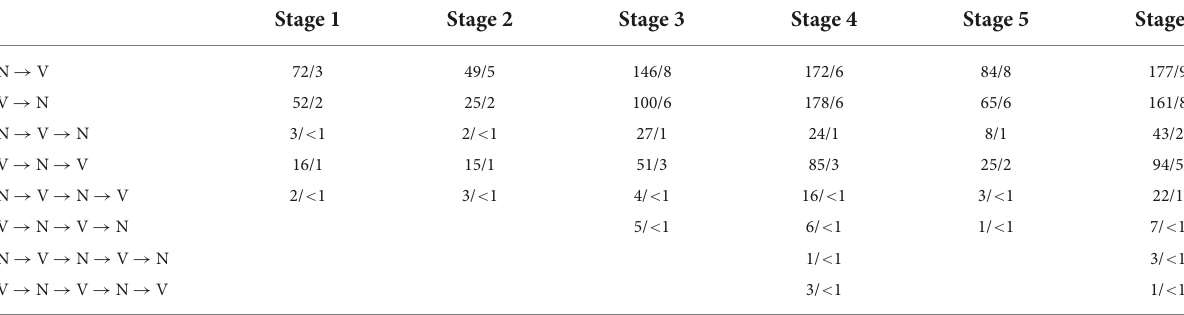
TABLE 4 Use of structures with word class change in CDS across developmental stages (N/no. per 100 utterances). Stage